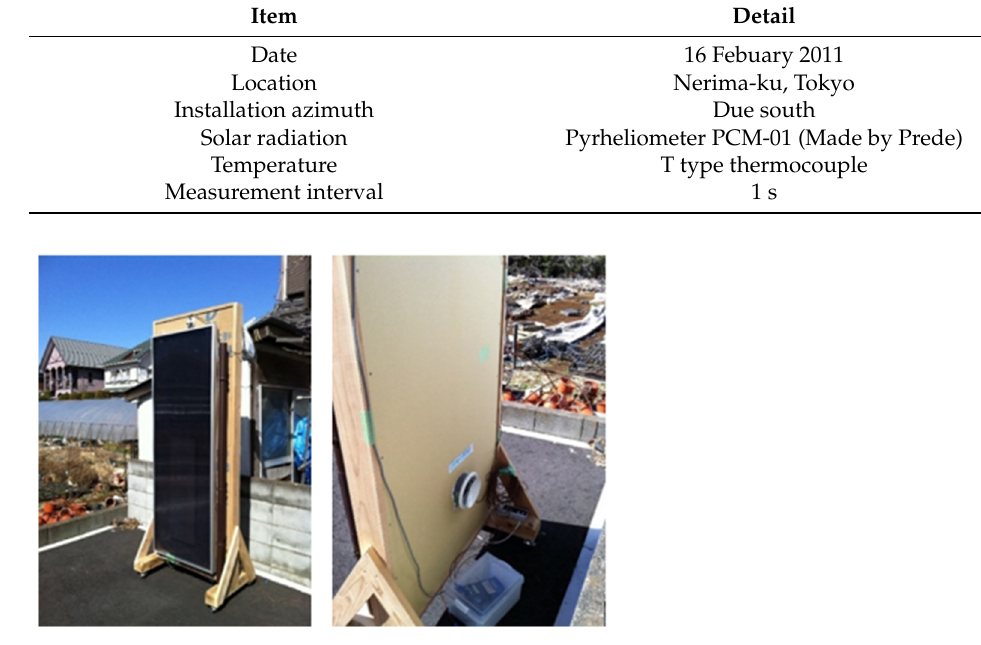
Figure 2. Experimental device.